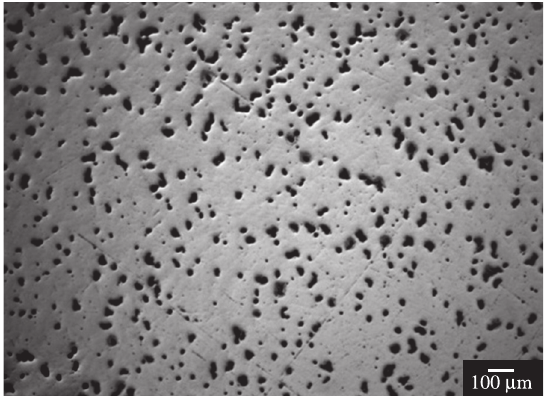
Figure 10. Microstructure of a sample pressed at 600 MPa and sintered on the cathode at 1423 K for 3600